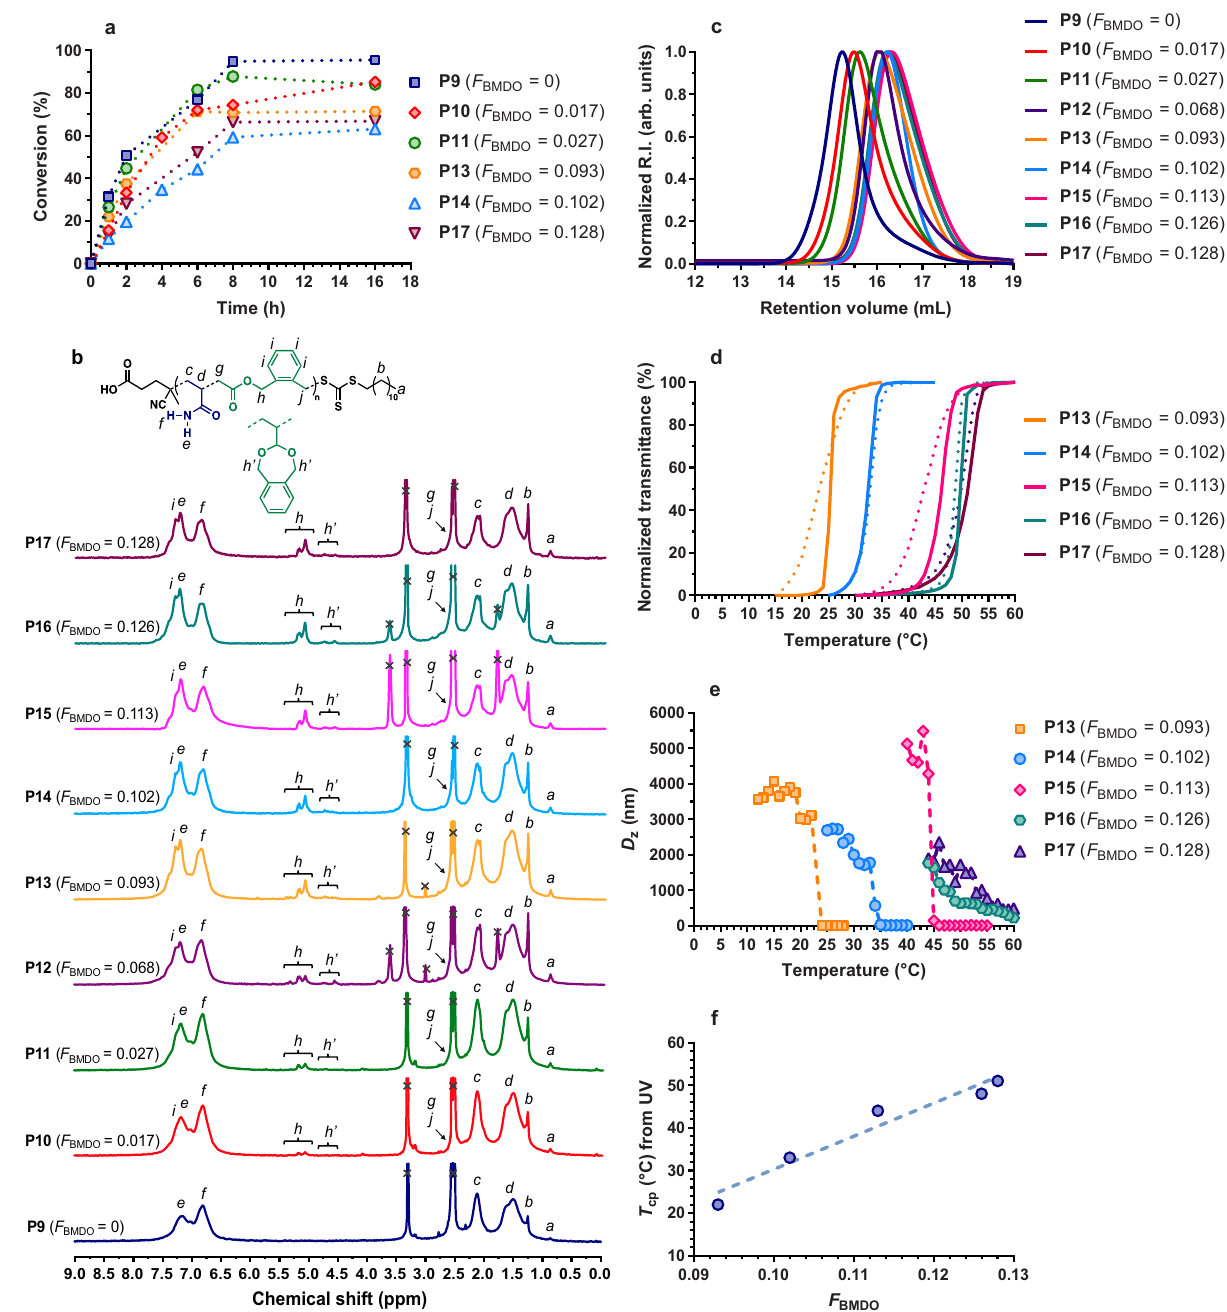
Fig. 4 Copolymerization kinetics and characterization of P(AAm- co -BMDO) copolymers. a Conversion vs. time kinetic plot from the RAFT polymerization of AAm with BMDO in anhydrous DMSO initiated by AIBN at 70 °C. Conversion = AAm conversion as determined by 1 H NMR; b 1 H NMR spectrum (300 MHz, DMSO-d 6 ) in the 0 – 9 ppm region of P(AAm- co -BMDO) copolymers P9 – P17 (Table 2); c evolution of the SEC chromatograms of P(AAm- co -BMDO) copolymers P9 – P17 as a function of F BMDO ; d variation of the solution transmittance vs. temperature of P(AAm- co -BMDO) copolymers P13 – P17 solution in water at 10 mg mL − 1 (1 °C min − 1 , solid and dotted lines for cooling and heating, respectively); e variation of the intensity average diameter ( D z ) from DLS vs. temperature of P(AAm- co -BMDO) copolymers P13 – P17 solution in water (10 mg mL − 1 ) upon cooling (1 °C min − 1 ); f evolution of T cp measured by UV upon heating as a function of F BMDO for copolymers P13 – P17 (the dashed blue line is a linear regression as guide for the eyes